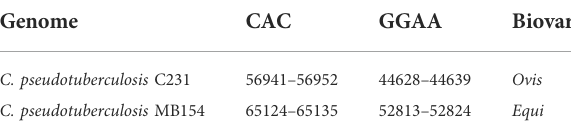
TABLE 4 Location of CAC and GGAA motifs for a test of biovar identi fi cation.